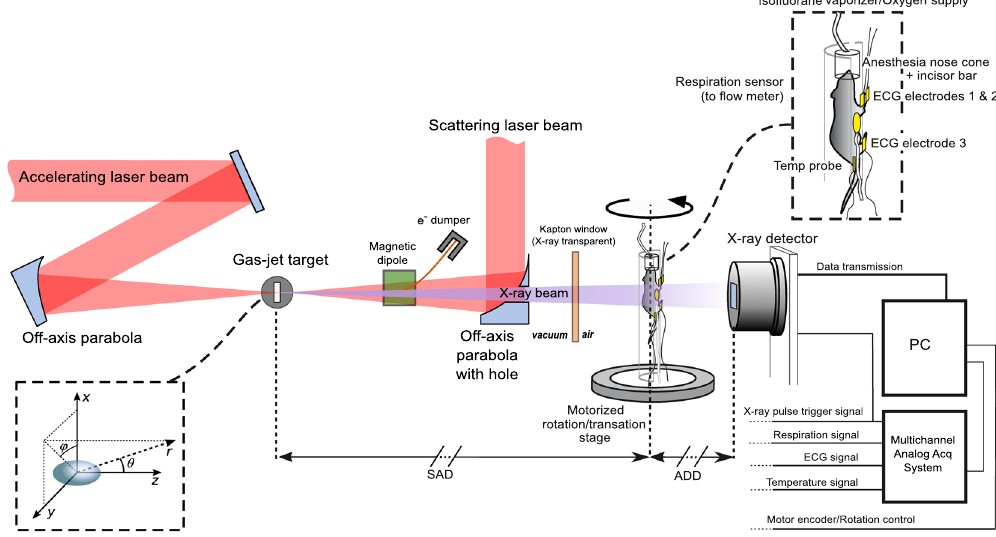
Figure 1. Conceptual scheme of the laser-based 4D μ CT scanner prototype for cardiac imaging of small